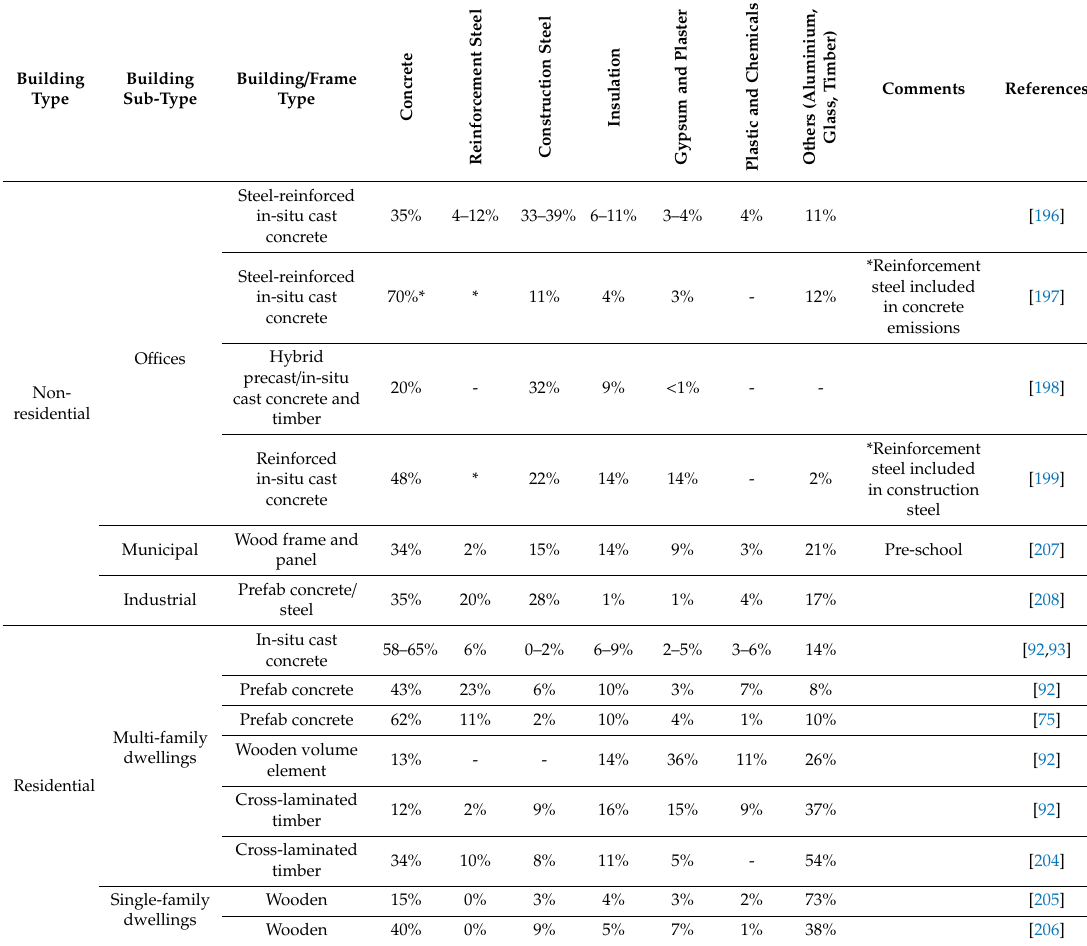
Table A5. Overview of the share of emission components from di ff erent materials in LCA literature for new builds of various building and frame